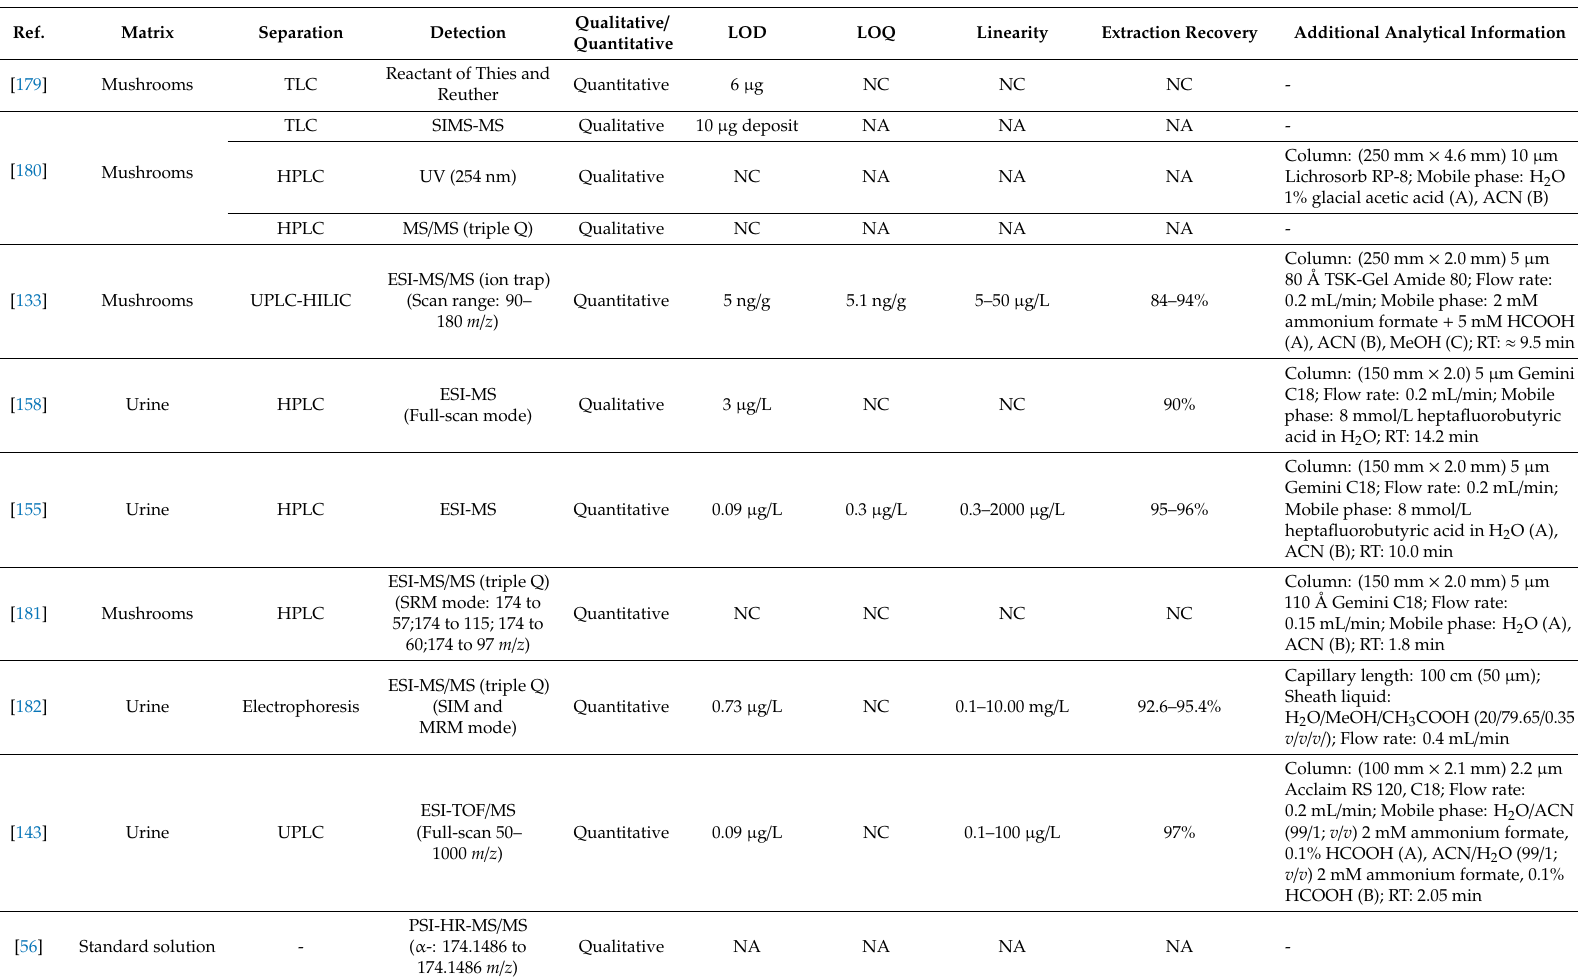
Table 6. Analytical methods for muscarine